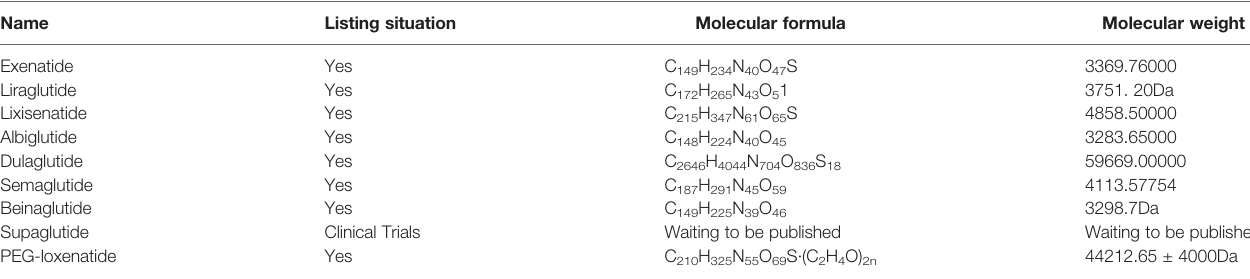
TABLE 1 | Classi fi cation of